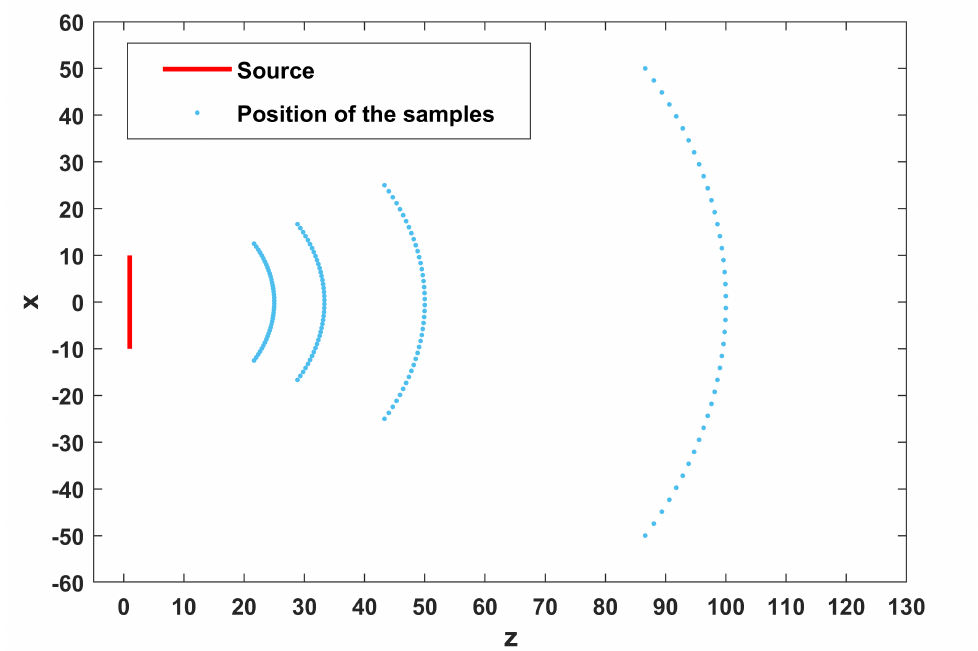
Figure 6. Grid of the optimal sampling points in the case χ =